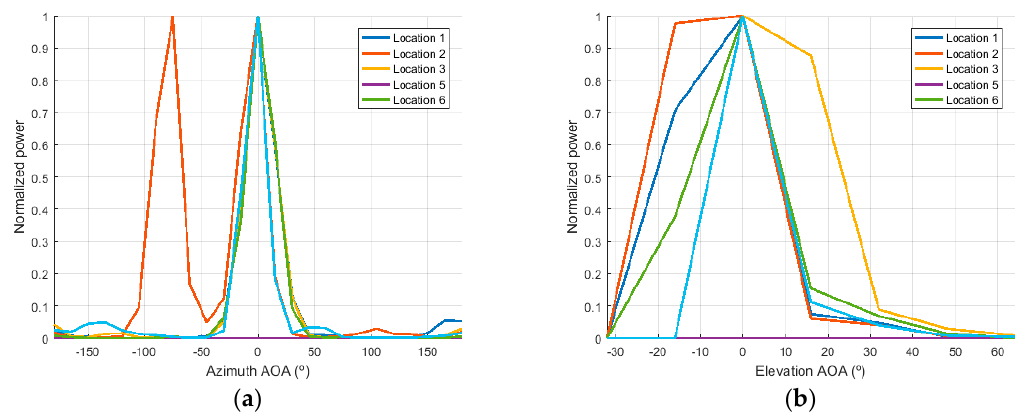
Figure 8. APDs for suburban environment ( a ) azimuth and ( b ) elevation.